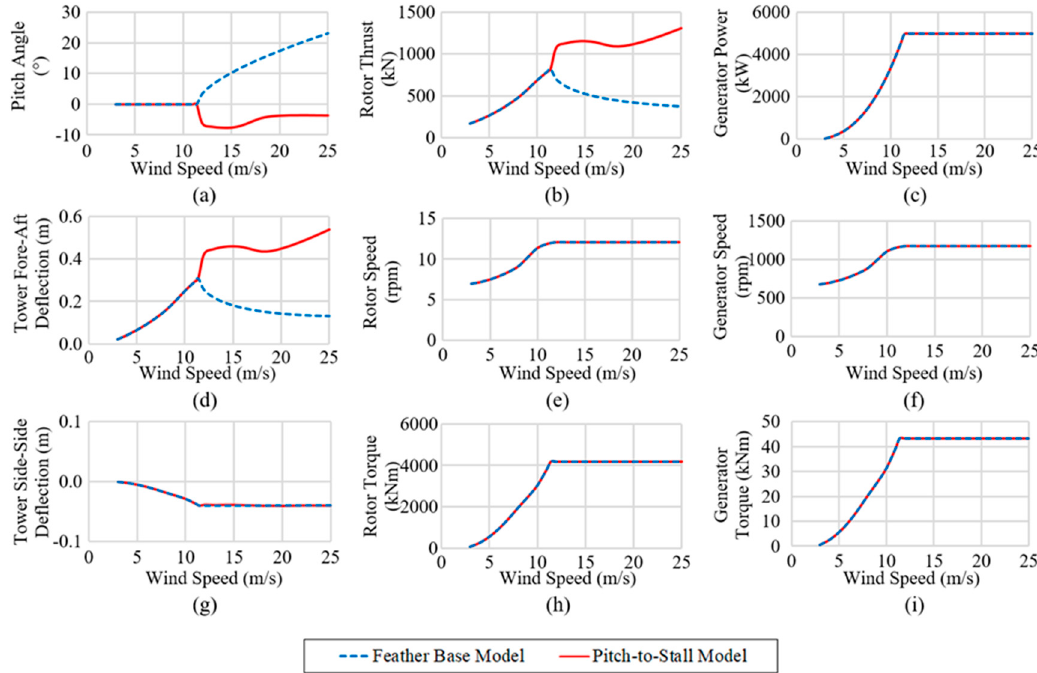
Figure 4. Simulated FOWT characteristics from periodic steady winds for two different blade models: (blue) pitch-to-feather and (red) pitch-to-stall. ( a ) pitch angle ( ° ); ( b ) rotor thrust (kN); ( c ) generator power (kW); ( d ) tower fore-aft deflection (m); ( e ) rotor speed (rpm); ( f ) generator speed (rpm); ( g ) tower side-side deflection (m); ( h ) rotor torque (kNm); ( i ) generator torque (kNm).